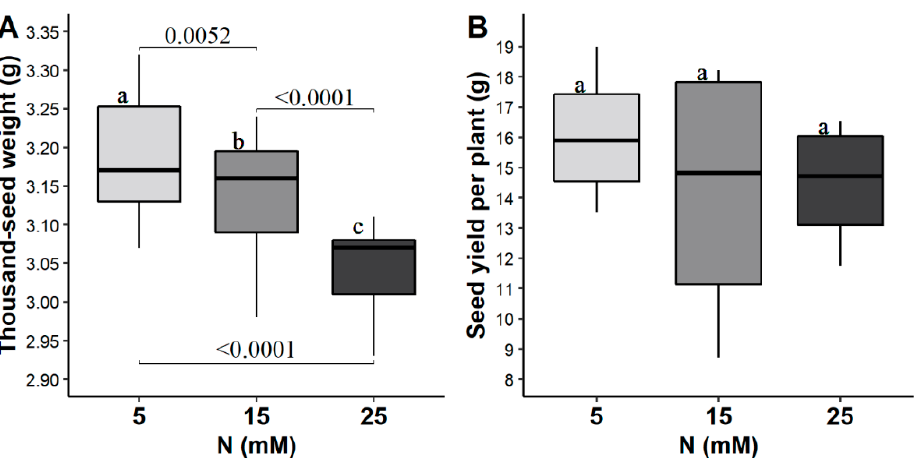
Figure 2. Seed weight ( A ) and seed yield per plant ( B ) from tomato plants fertigated with solutions of 5, 15 or 25 mM nitrogen (N) concentration. Different letters represent a significant difference ( p < 0.05). Numbers above the brackets represent p -values for contrasts between treatments.